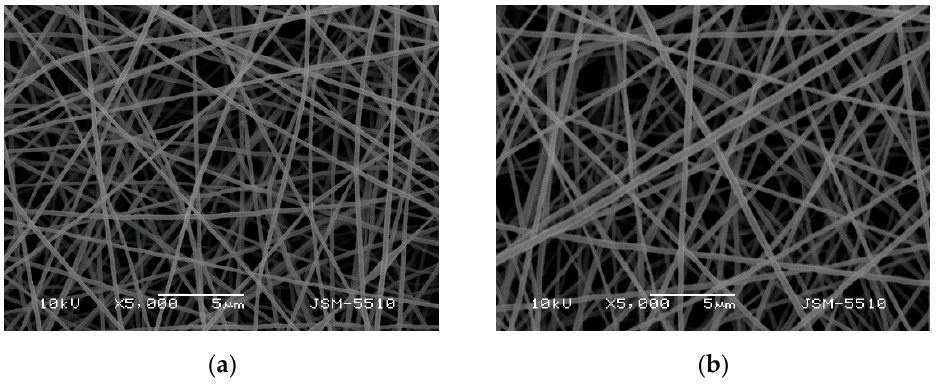
Figure 1. SEM micrographs of electrospun mats of: PVA/Ch/SQ (5 wt% SQ) ( a ), PVA/Ch/SQ (10 wt% SQ) ( b ); magnification x 5000.